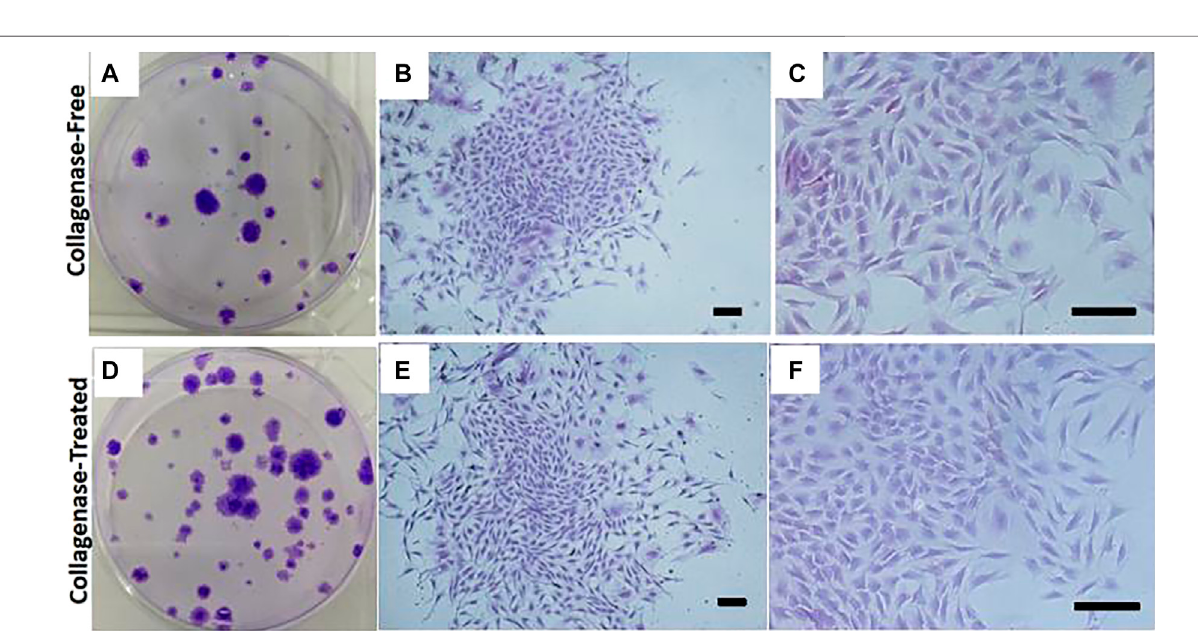
Frontiers in Bioengineering and Biotechnology |